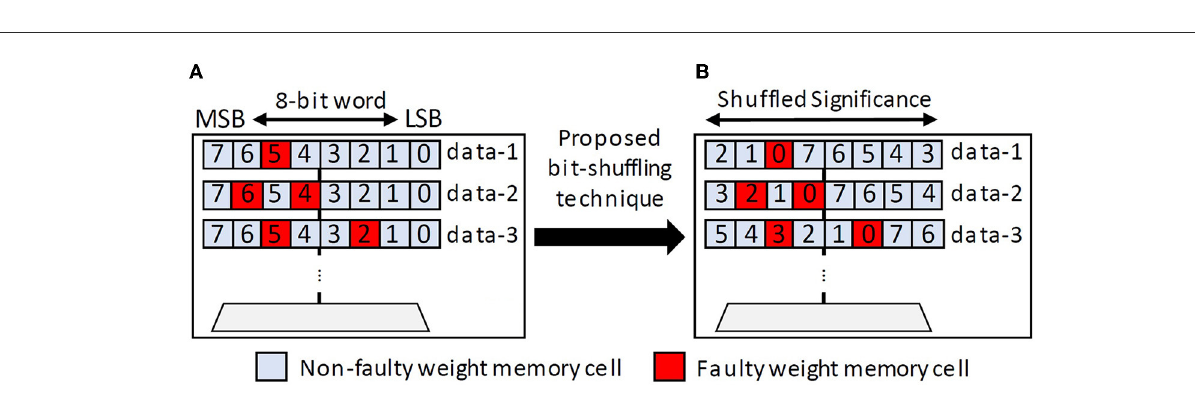
FAM3) for different possible fault maps on the compute